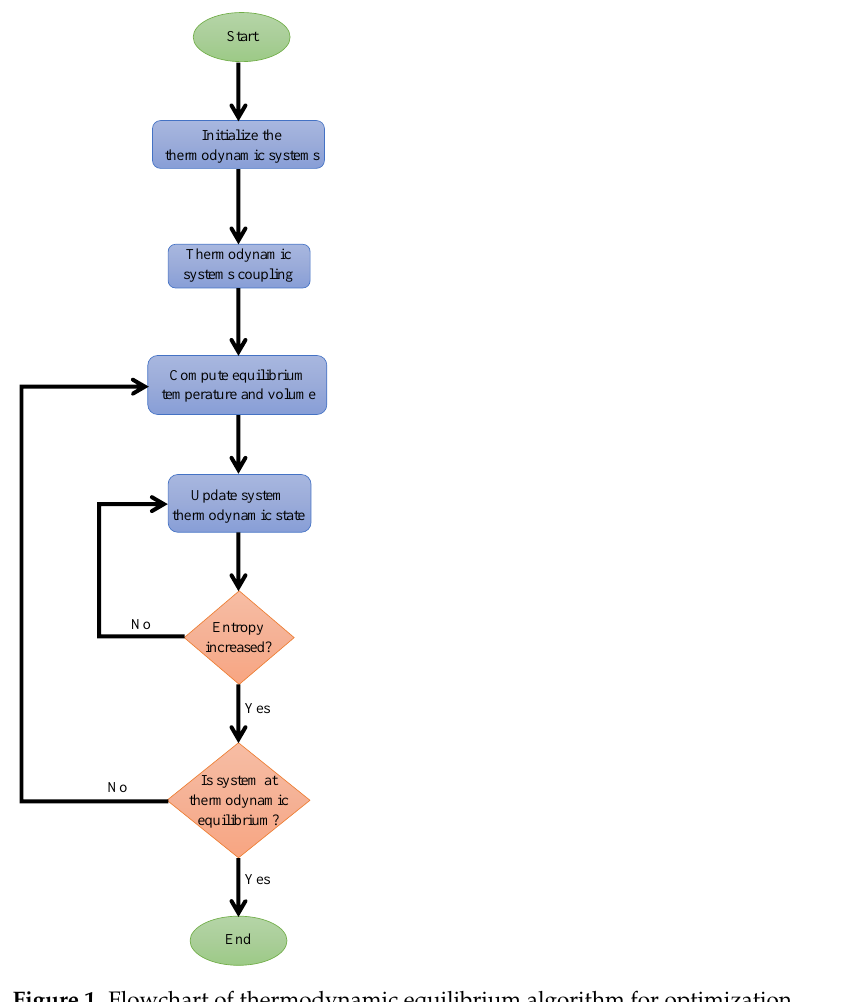
Figure 1. Flowchart of thermodynamic equilibrium algorithm for